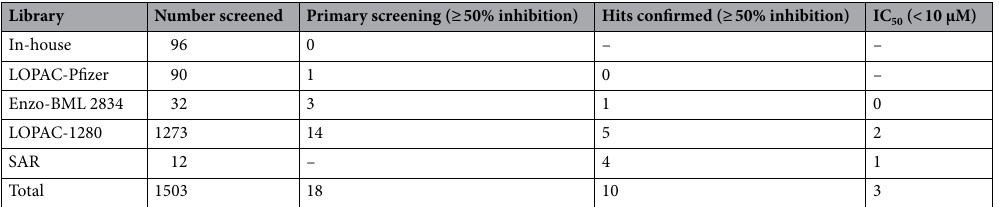
Table 1. Summary of compounds screened from commercial and in-house libraries and structure–activity relationship (SAR)